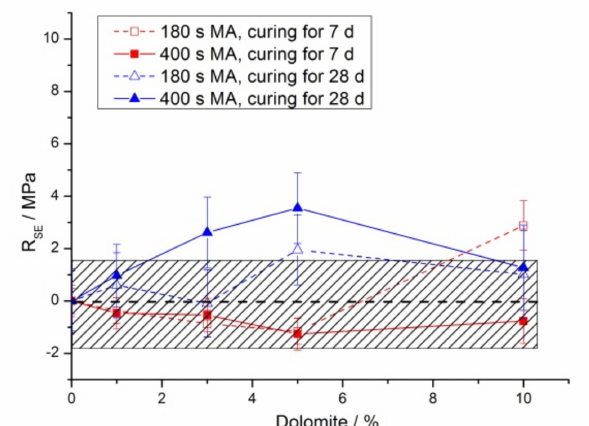
Figure 7. Increment of the synergistic effect (R SE ) in the strength of geopolymers based on the FA + dolomite blends at the age of 7 and 28 days. The shaded area includes the data for which the R SE is close to